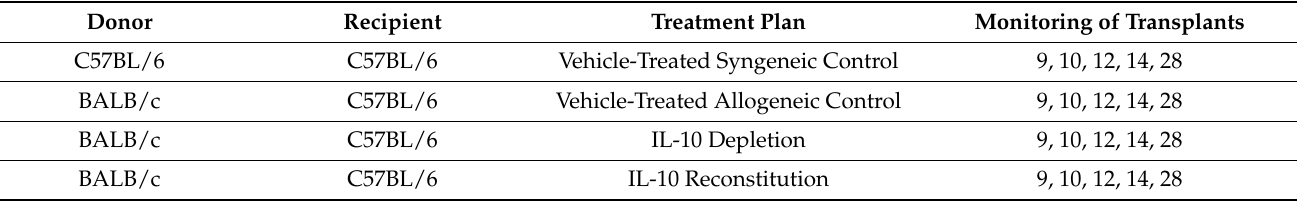
Table 1. Experimental